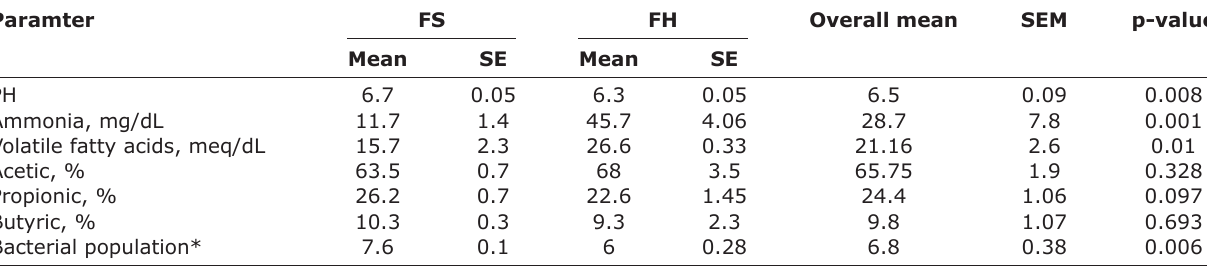
Table-3: Rumen fermentation parameters and bacterial population in the rumen of camels fed different forage types. Paramter FS